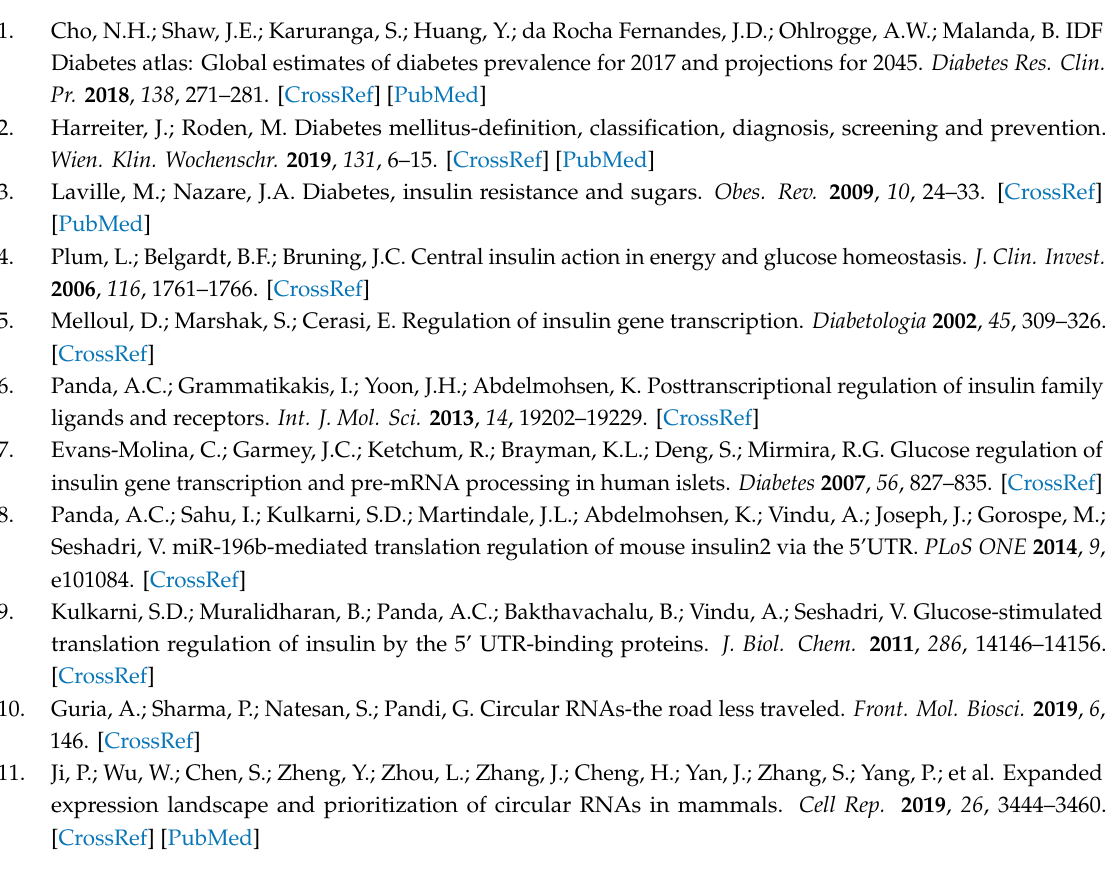
Figure S1: Characteristics of circRNAs in mouse pancreatic islets. Figure S2: Selected list of circRNAs from RNA-seq data. Figure S3: Validation of circRNAs in β TC6 cells. Figure S4: Validation of circular Ins2 transcripts in islets. Figure S5: Lariat branchpoint sequence of ci-Ins2_415. Figure S6: Sequence of ci-Ins2 transcripts. Table S1: List of oligos used for the study. Table S2: circRNA annotation by CIRCexplorer2. Table S3: circRNA annotation by CIRI2. Table S4: List of circRNAs derived from mouse Ins1 and Ins2 gene detected using CIRCexplorer2. Table S5: List of RBPs and the number of binding sites predicted in di ff erent regions of mouse Ins2 pre-mRNA using beRBP. Table S6: CircRNA–miRNA–mRNA regulatory network for ci-Ins2 (486